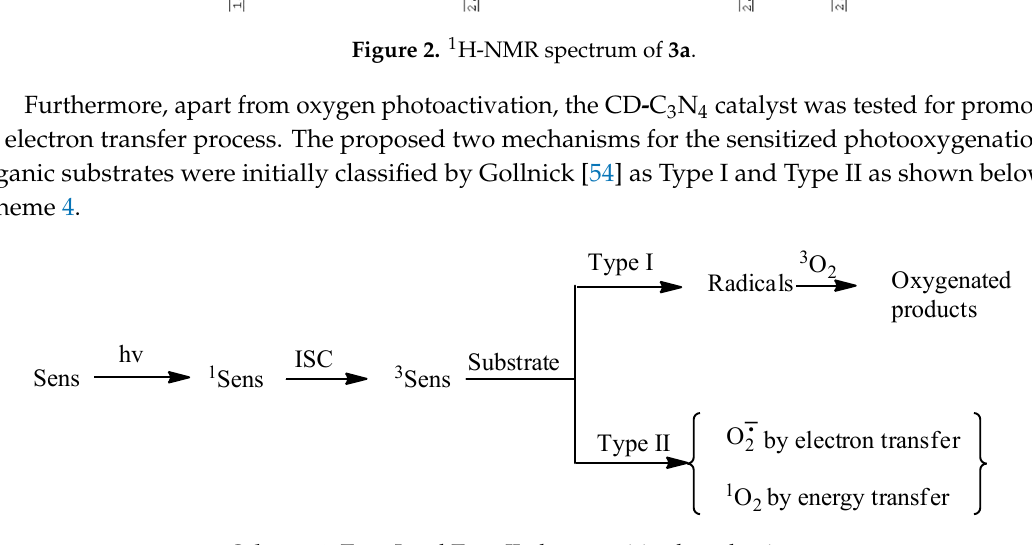
Scheme 4. Type I and Type II photosensitized mechanisms.